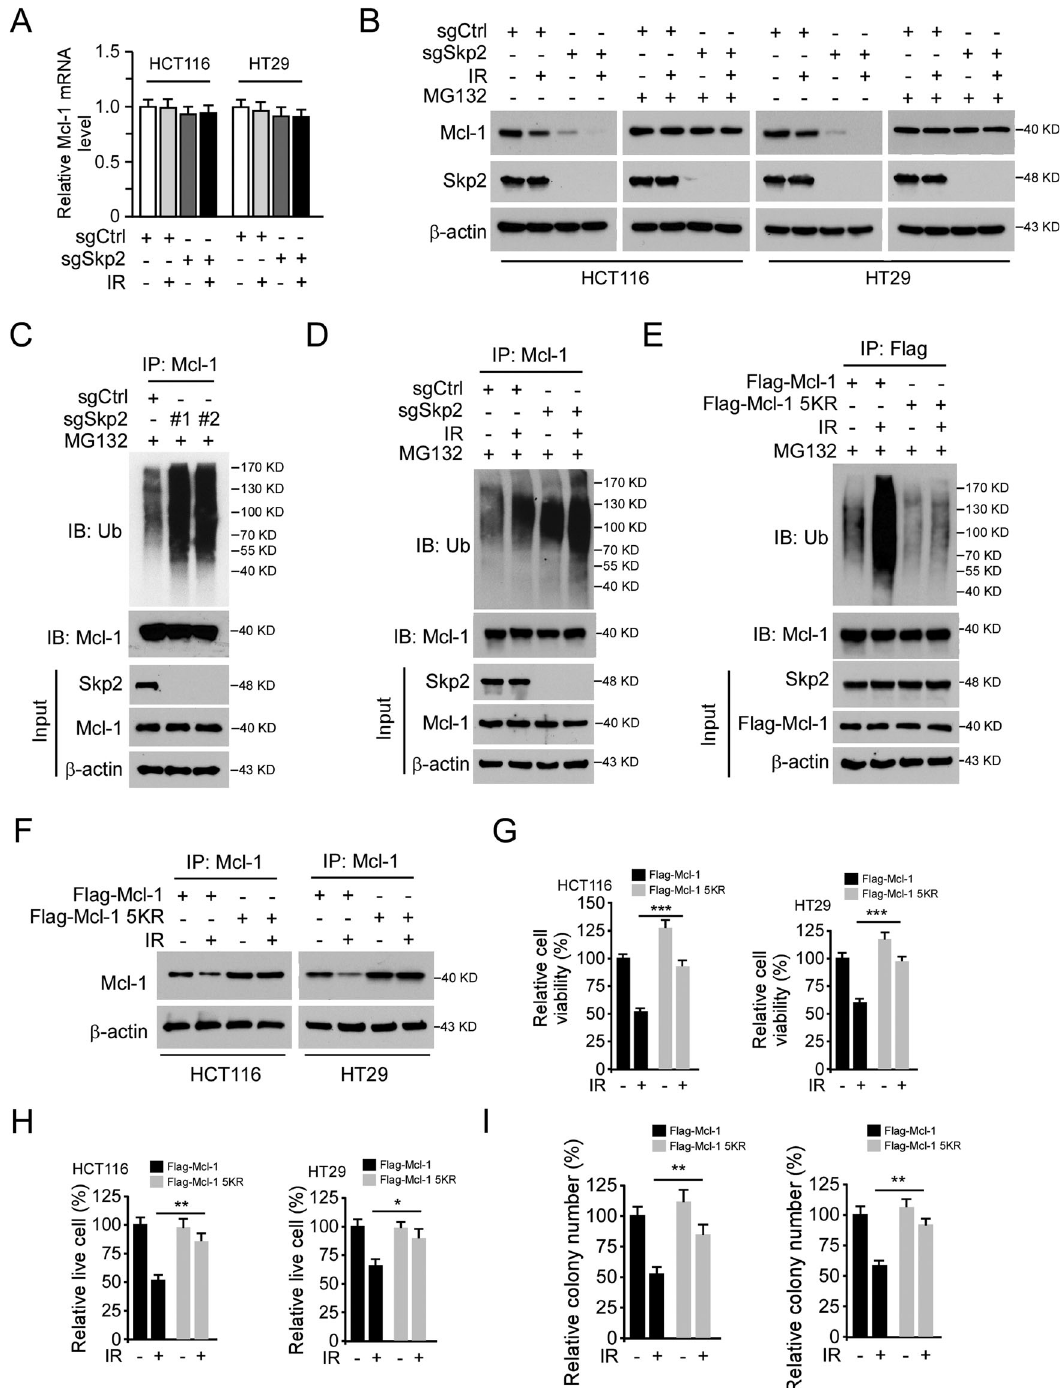
Fig. 4 Irradiation promotes Mcl-1 ubiquitination and degradation. A Mcl-1 mRNA expression in Skp2 depleted CRC cells with IR treatment was examined by real-time RT-PCR. B Skp2 depleted HCT116, and HT29 cells were treated with IR (2 Gy) and cultured for 72 h, MG132 (25 μ M) was added to the cell culture medium and maintained for 6 h. WCE was subjected to IB analysis. C Skp2 knockout HCT116 cells were treated with MG132 for 6 h, WCE was prepared and subjected to Mcl-1 ubiquitination analysis. D Skp2 depleted HCT116 cells were treated with MG132 (25 μ M) for 6 h, followed by IR (2 Gy) treatment and cultured for 1 h. WCE was subjected to Mcl-1 ubiquitination analysis. E Flag-Mcl-1 wild type or 5KR mutant was transfected into HCT116 cells using lipofectamine 2000 for 48 h and treated with IR as indicated. WCE was extracted after IR treatment for 1 h and subjected to Mcl-1 ubiquitination analysis. F Flag-Mcl-1 wild type or 5KR mutant was transfected into HCT116 cells for 24 h, followed by IR (2 Gy) treatment, and cultured for 72 h. WCE was subjected to IB analysis. G – I Flag-Mcl-1 wild type or 5KR mutant was transfected into HCT116 and HT29 cells for 24 h, followed by IR (2 Gy) treatment and cultured for 72 h. Cell viability and live cell population were determined by MTS assay ( G ) and trypan blue exclusion assay ( H ), respectively. Colony formation was examined by plate colony formation assay ( I ). * p < 0.05, ** p < 0.01, *** p < 0.001.